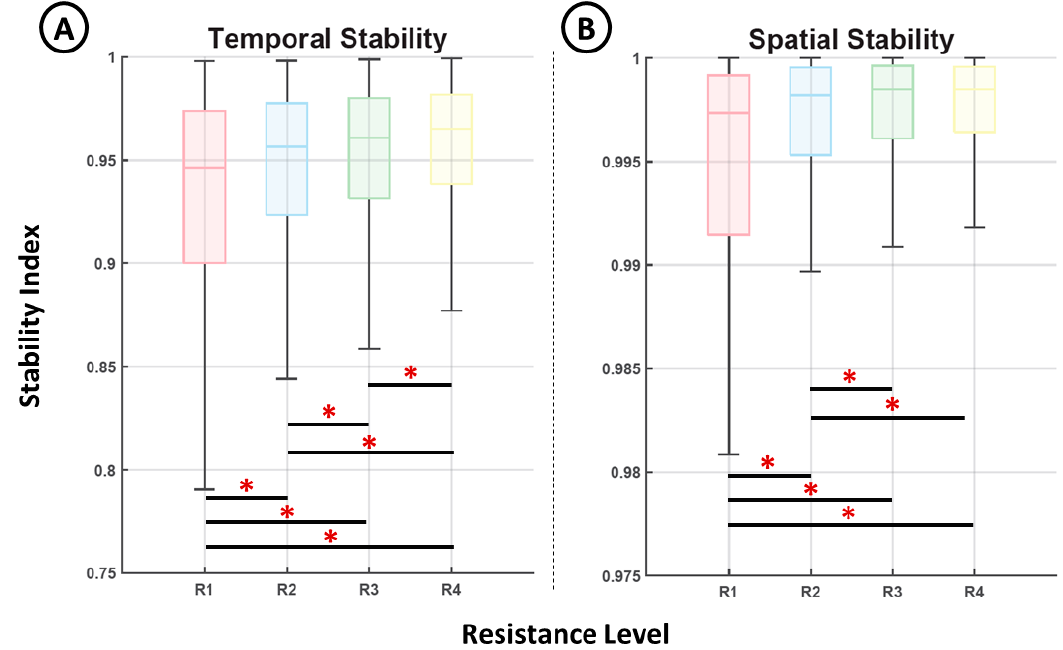
Figure 6. Comparison of the temporal stability index ( A ) and the spatial stability index ( B ) for each resistance level (*, p < 0.05).